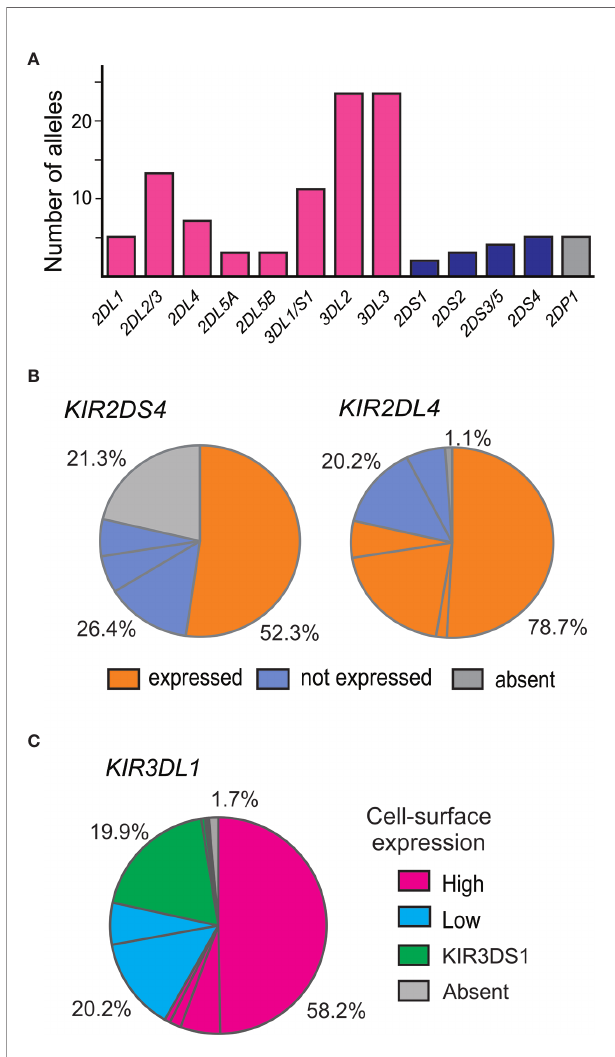
FIGURE 2 | KIR alleles present in the Zhejiang Han population. (A) Shown is the total number of KIR alleles observed in 176 Zhejiang Han. Genes encoding inhibitory KIR are indicated by red bars, activating by blue bars, and pseudogenes by gray bars. (B) Shown are the ratios of expressible and non-expressed alleles of KIR2DS4 and KIR2DL4 in Zhejiang Han. Each pie segment represents a distinct allele, orange indicates allele can be expressed at the cell surface, blue indicates not expressed, grey indicates gene absent. (C) Shown is the KIR3DL1 allele expression frequency spectrum in Zhejiang Han. Magenta indicates high expression alleles, cyan — low expression, green — KIR3DS1 (activating receptor) and gray indicates gene absence or unknown expression